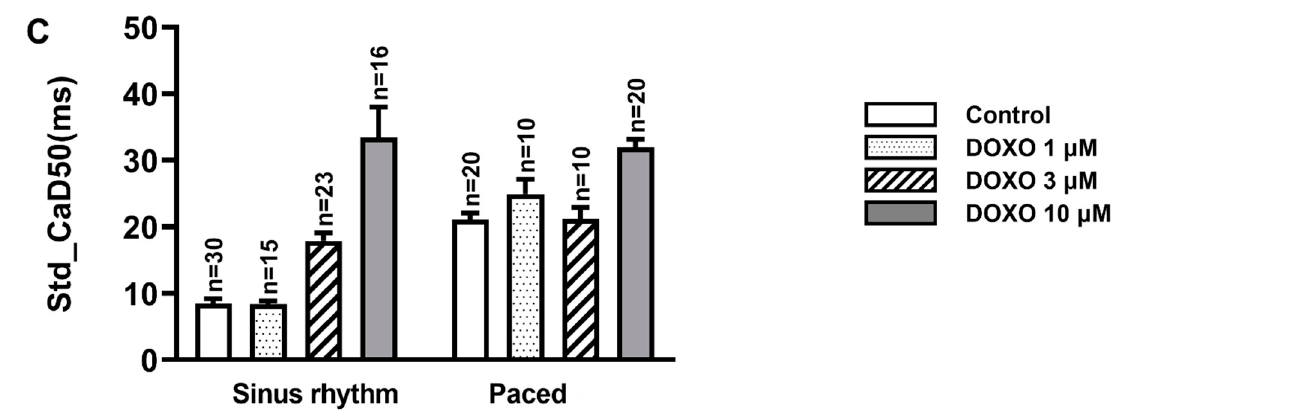
Figure 3. ( A , B ) An example mapping of the Ca 2+ signal duration at 50% amplitude (CaD50) before ( A ) and after ( B ) the application of DOXO 10 µ M in a heart with sinus rhythm. ( C ) The standard deviation (STD) of CaD50 in the sinus and paced groups. In the sinus group, DOXO 3 µ M and 10 µ M significantly increased the STD ( p < 0.01), and in the paced group, DOXO 10 µ M significantly increased the STD ( p < 0.01). Compared to the sinus group, tachypacing (300 bpm) increased the STD ( p < 0.01, sinus control vs. paced control).